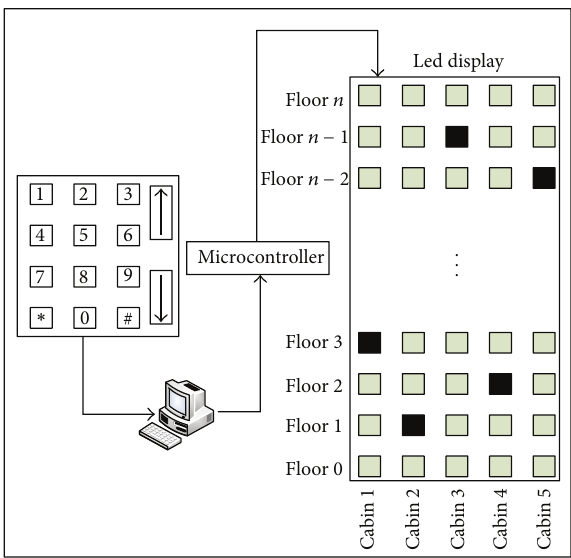
Figure 7: Hardware module.